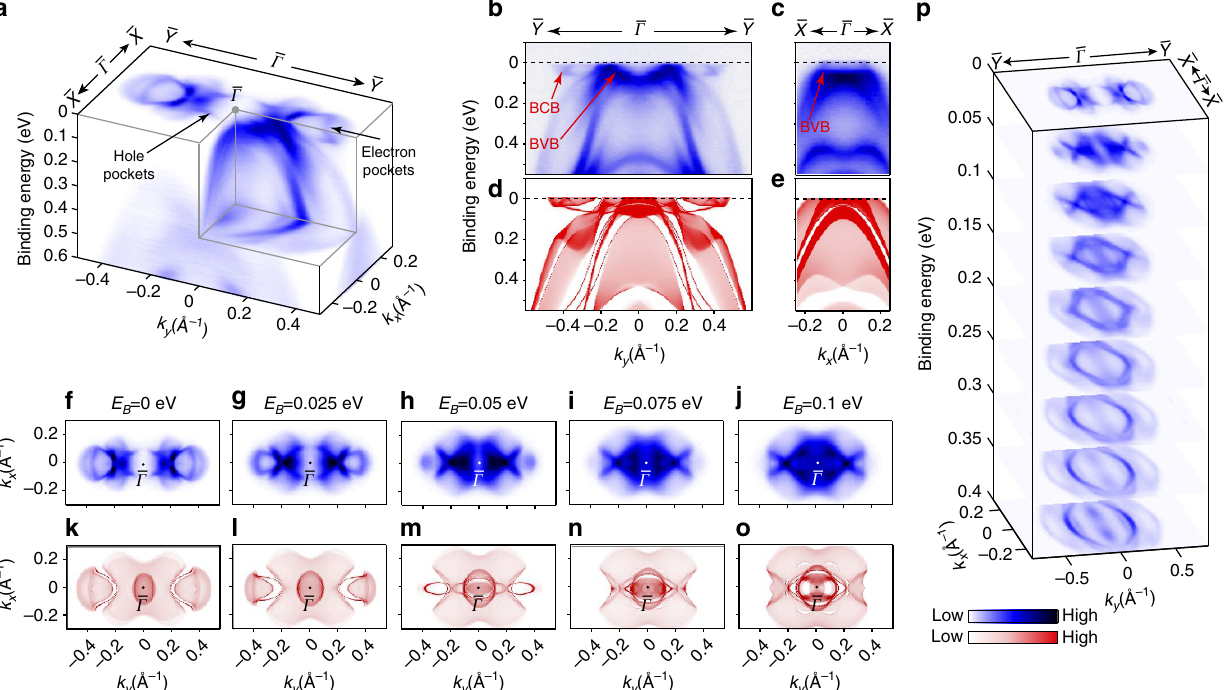
Figure 2 | General electronic structure of T d -MoTe 2 . ( a ) The 3D intensity plot of the photoemission spectra around (cid:2) G , with the electron and hole pockets indicated. ( b , c ) High symmetry cut along the (cid:2) Y (cid:2) G (cid:2) Y and (cid:2) X (cid:2) G (cid:2) X directions, respectively. BCB, bulk conduction band; BVB, bulk valance band. ( d , e ) The corresponding calculations along the (cid:2) Y (cid:2) G (cid:2) Y and (cid:2) X (cid:2) G (cid:2) X directions, respectively. ( f – j ) Photoemission spectral intensity map showing the constant energy contours of bands at E B ¼ 0, 0.025, 0.05, 0.075 and 0.1eV, respectively. ( k – o ) Corresponding calculated constant energy contours at the same binding energies as in experiments above. ( p ) Stacking plots of constant-energy contours in broader binding energy range show the band structure evolution. NATURE COMMUNICATIONS|8:13973|DOI: